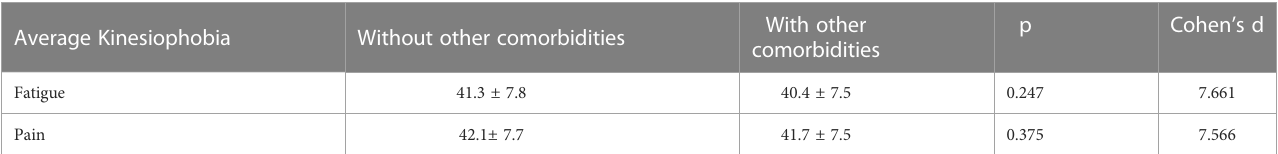
TABLE 7 Level of Kinesiophobia according to other comorbidities.